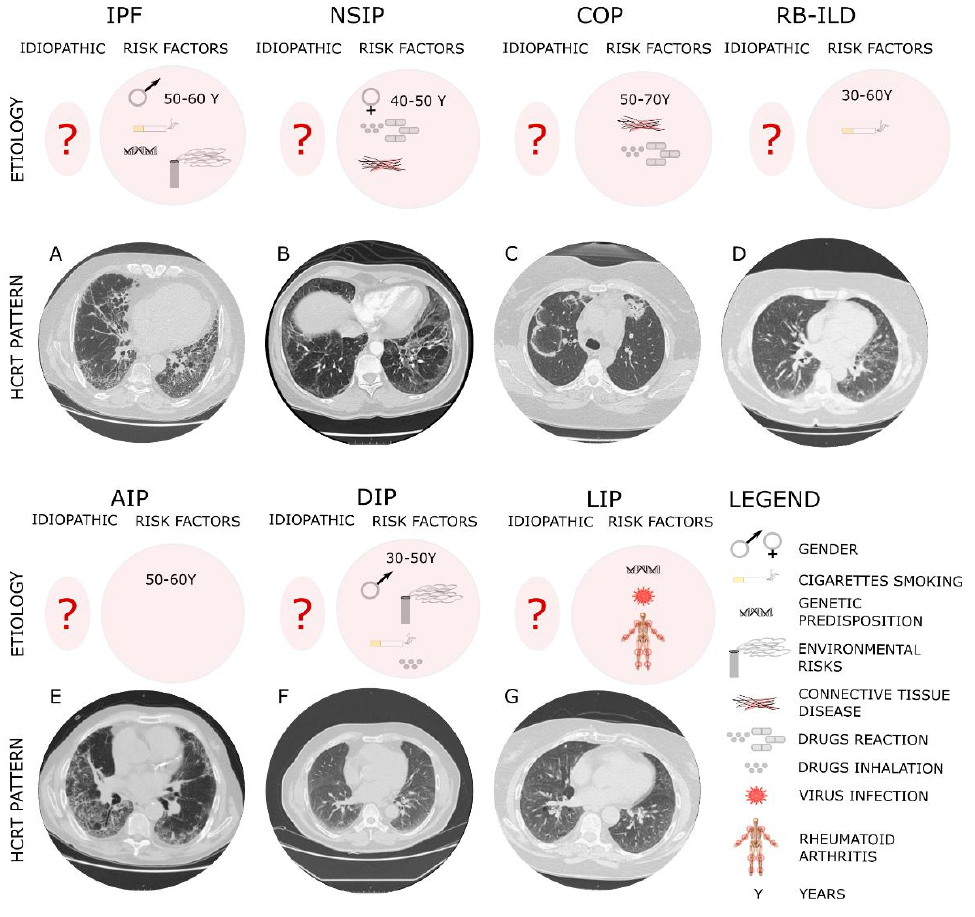
Figure 1. The diagnostic and etiologic characteristic of different IIPs.